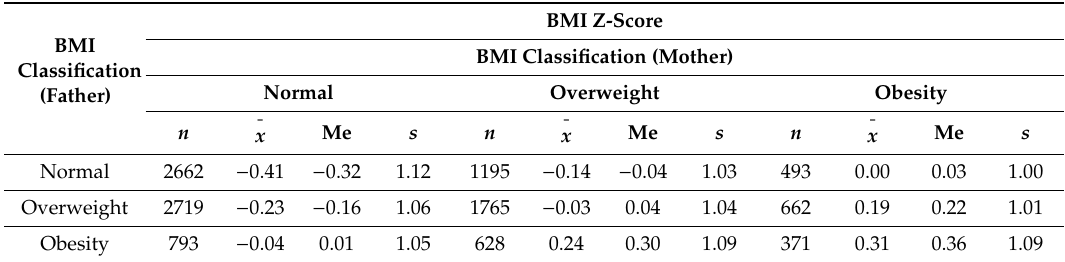
Table 5. Mean BMI z-score of children in relation to the BMI classification of mothers and